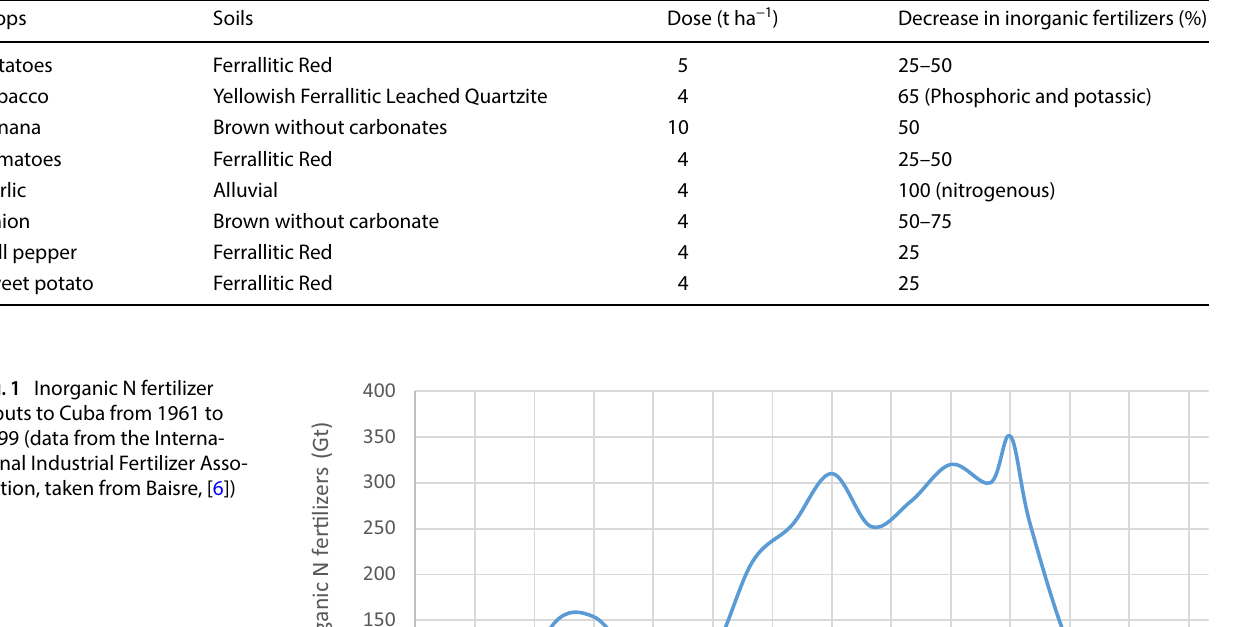
Table 1 Use of earthworm humus in different crops [5]